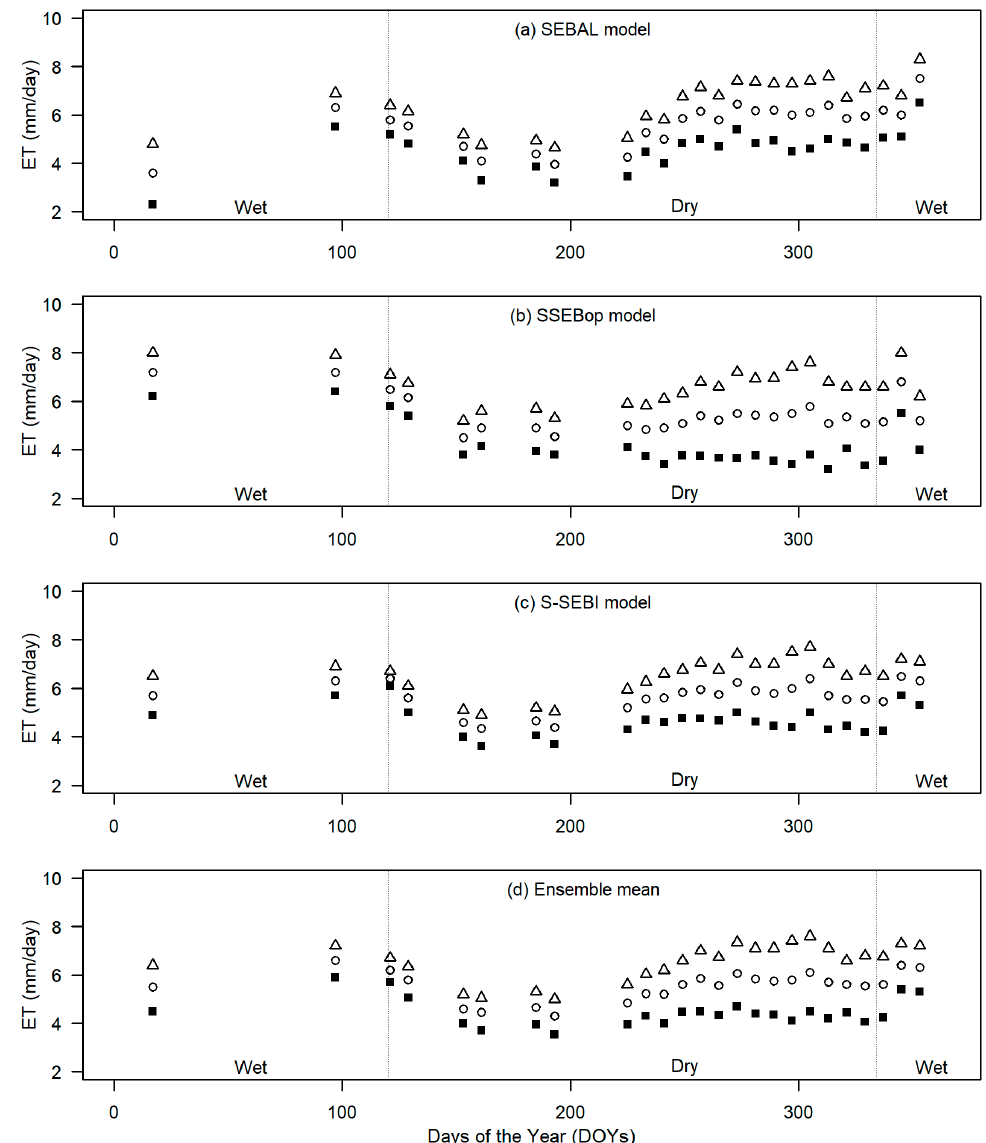
Figure 5. The daily basin average dynamics of evapotranspiration (ET) over the Kilombero Valley (KV) river basin for 25 days of the year (i.e., MODIS satellite overpasses). The dashed vertical lines represent the boundary between the wet season (Wet) and the dry season (Dry), open triangles represent the uplands (mountain-forests), open circles represent the entire basin, and filled rectangles represent the wetland-valley (Floodplain). ( a ) ET derived using the SEBAL model, ( b ) ET derived using the SSEBop model, ( c ) ET derived using the S-SEBI model, and ( d ) ET derived using the ensemble mean of the three models. It should be noted that this figure composites daily results from 3 separate years.